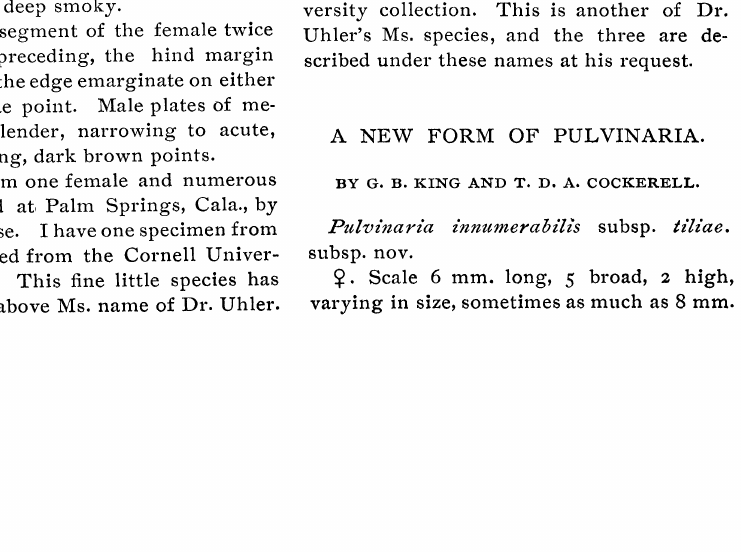
veins paler, the inner apical all transparent. Wings